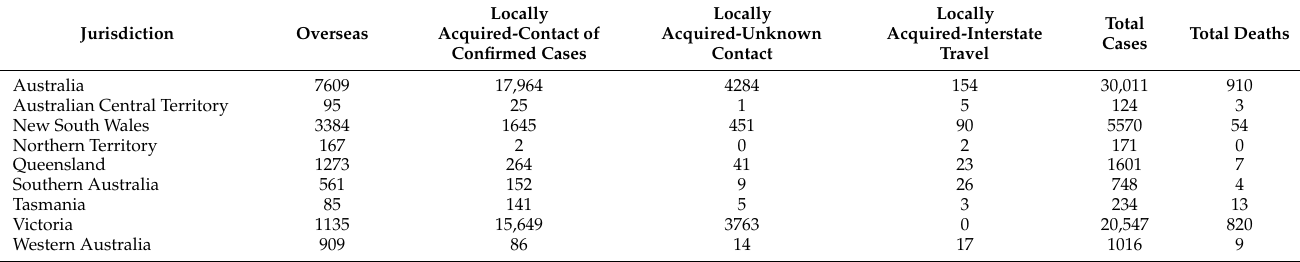
Table 1. Total COVID-19 cases and deaths in Australia, separated by each jurisdiction by the source of infection [23]. Last updated 22 May